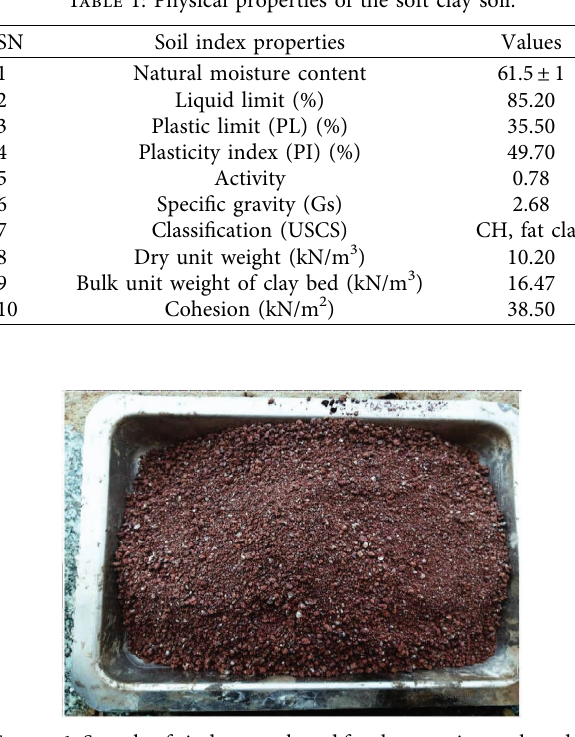
Table 1: Physical properties of the soft clay soil. Table 2: Physical properties of cinder gravel